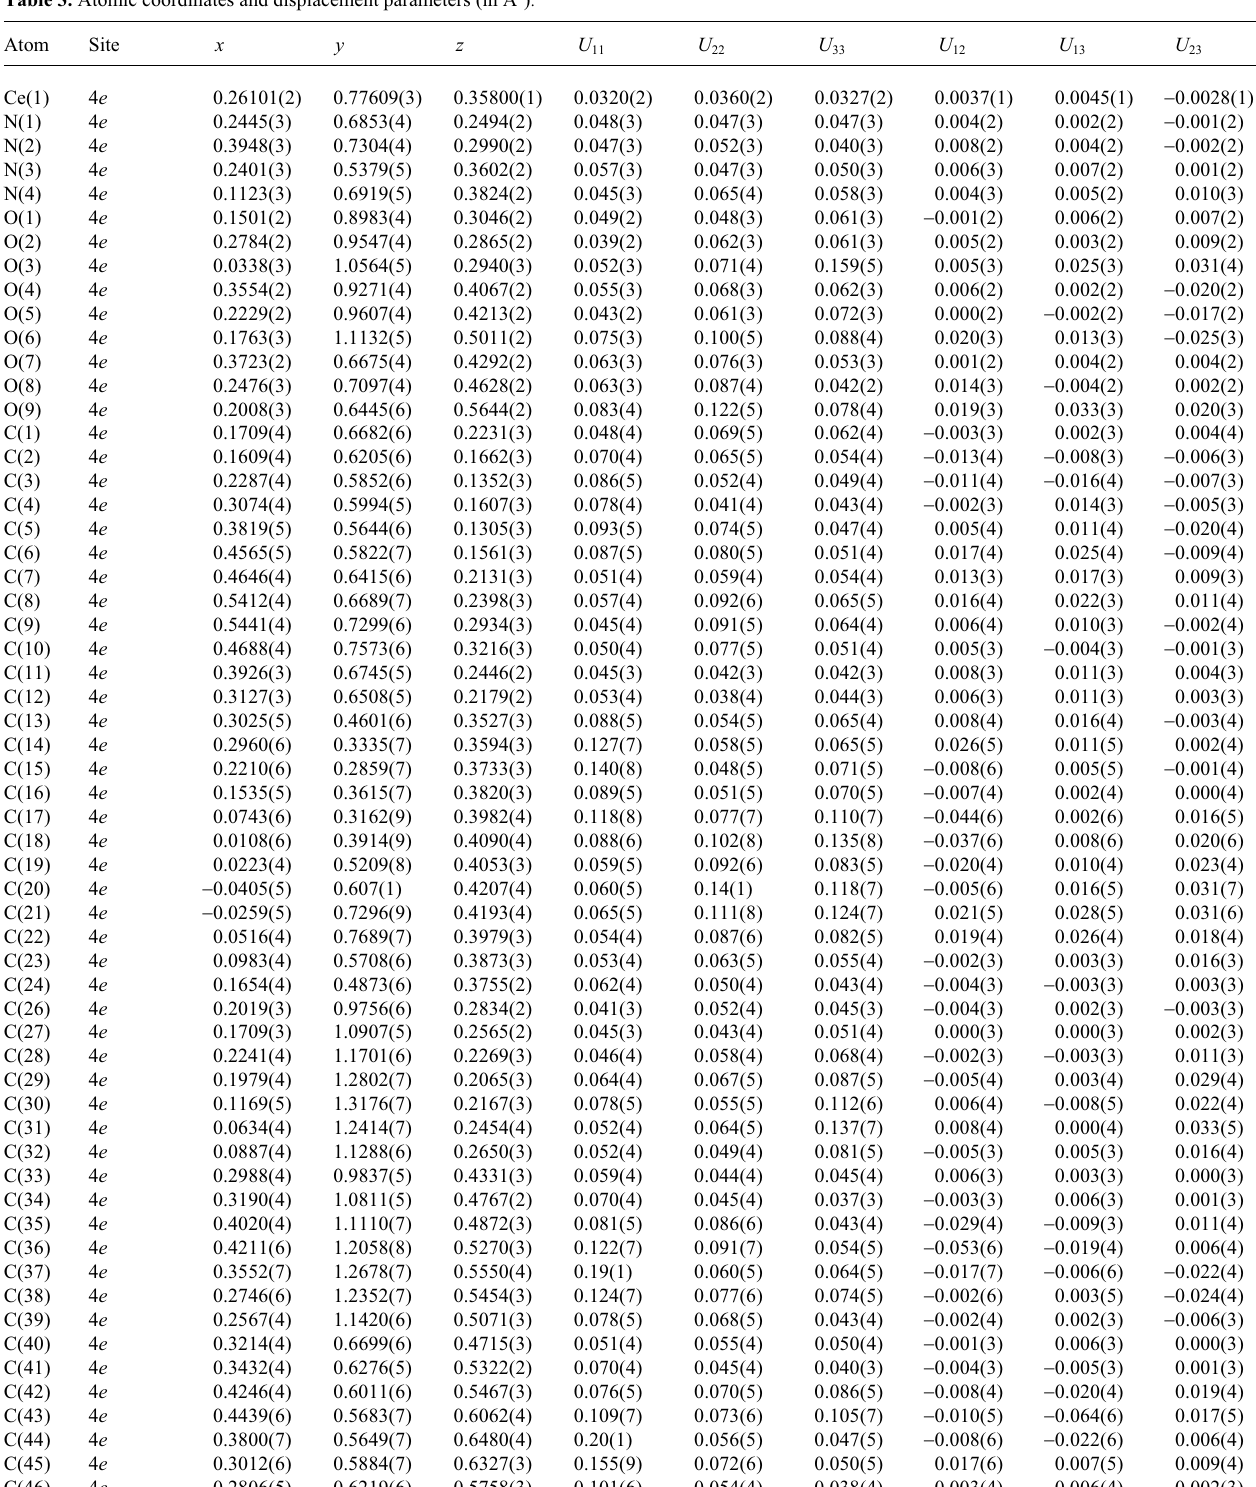
Table 3. Atomic coordinates and displacement parameters (in Å 2 )